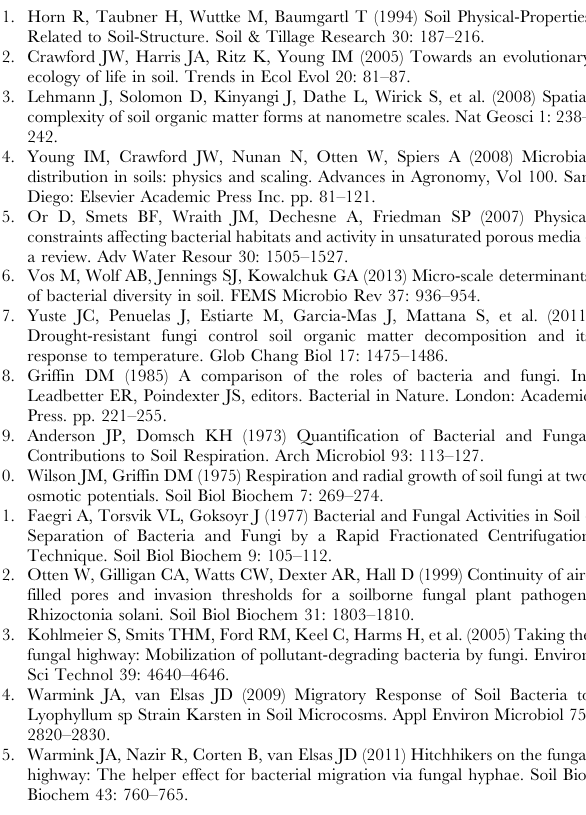
Figure S4 Antagonism assay of Streptomyces colonies overlaid with Bacillus in soft-agar. Zones of inhibition around the colonies indicate the production of an inhibiting compound by Streptomyces . Table S1 Constants of water retention curves according to the model of van Genuchten as expressed by the equation S e = [1 + ( a h)n] –m with S e = ( h h – h r )/( h s – h r ) and the suction h (cm), h r and h s are the residual and saturated soil water contents (cm 3 cm 2 3 ). S e is the effective saturation; the parameters a , m, and n are empirical and determined by a best-fit procedure; a is a parameter related to the inverse of the air entry suction (cm 2 1 ), n is a dimensionless curve shape parameter and s is the slope of h h